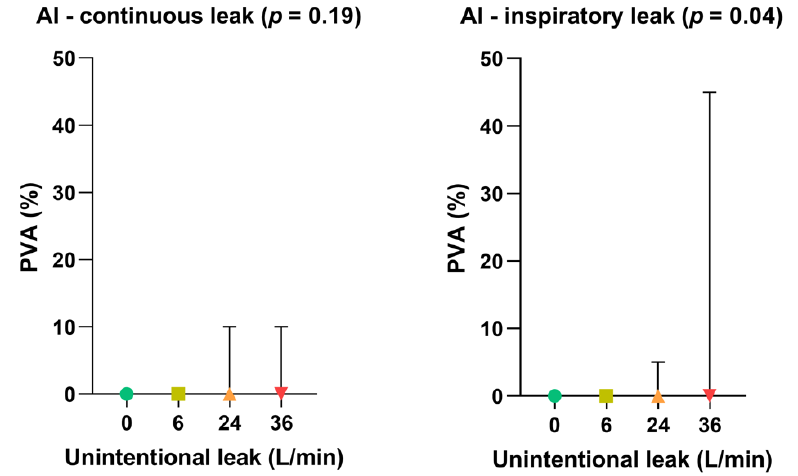
Figure 5. Consolidated data integrating the 3 respiratory models/devices without flow limitation according to the pattern of unintentional leak (continuous versus inspiratory) on patient-ventilator asynchrony (PVA) rates. Symbols and associated bars represent the median values and interquartile ranges. Liter per minute (L/min): Asynchrony Index (AI).